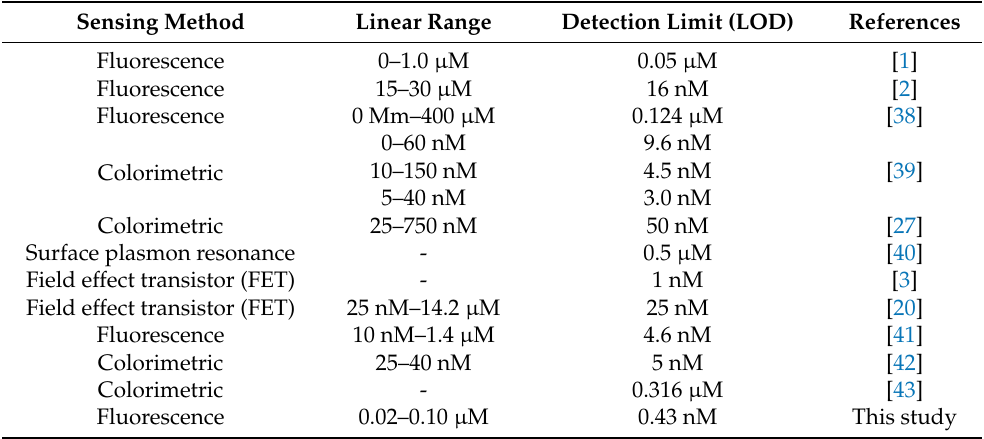
Figure 3. ( A ) The fluorescence intensity of GO-DNA sensor after adding different concentrations of Hg 2+ . ( B ) The value of F/F 0 -1 after adding different concentrations of Hg 2+ . F and F 0 were the fluorescence intensity of after adding Hg 2+ , and before adding Hg 2+ . ( C ) The illustration showed a linear relationship between low concentrations of Hg 2+ and F/F 0 -1. Table 1. The comparison of our method with other methods for Hg 2+